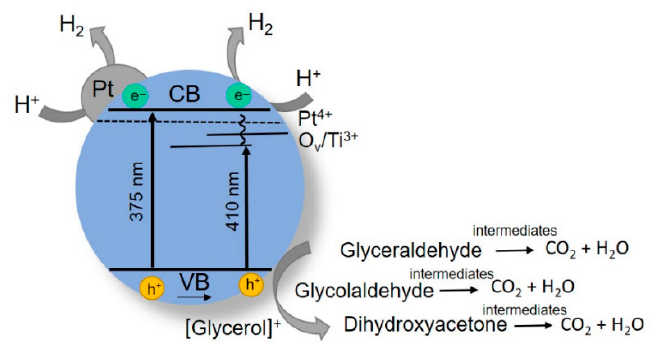
Figure 5. Scheme of photoprocesses for HER in presence of defective Pt/TiO 2 catalyst. 3.4. Electrochemical Analysis of the Photocatalytic Activity of Dark Pt/TiO 2 Obtained by PLAL